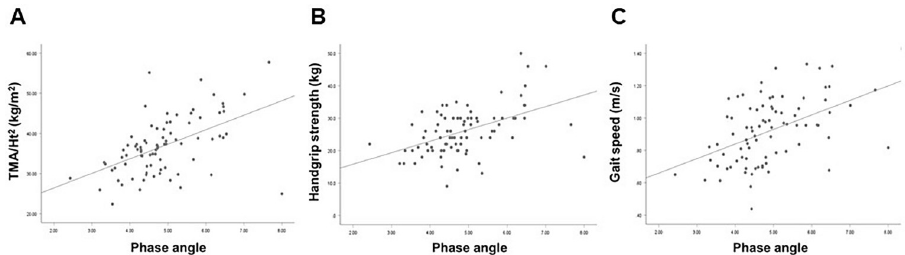
Fig 1. Correlation between phase angle and TMA/Ht 2 (A), HGS (B), and GS (C). Abbreviations: TMA/Ht 2 , thigh muscle area per height squared; HGS, handgrip strength; GS, gait